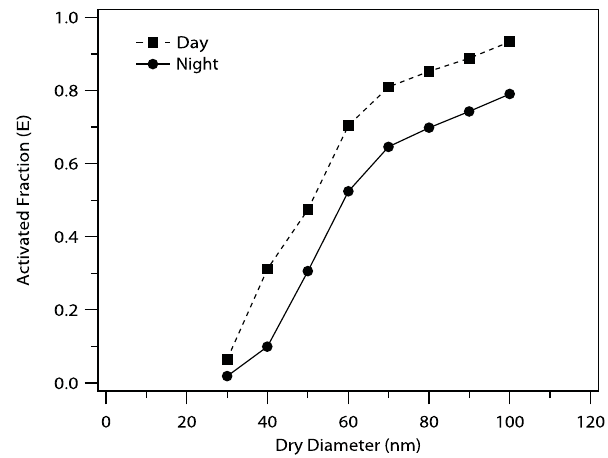
Fig. 8. Example of activation fraction as function of particle size for a day (square) and night (circle) sample. The smaller the particles the more externally mixed they become (smaller E ).